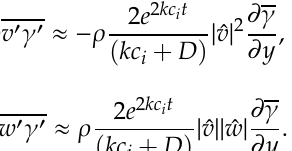
Figure 6. Phase angles for the meridional wind ( ξ v ; black), vertical wind ( ξ w , blue) and dust mixing ratio ( ξ γ ; red) at ( a ) 18 ◦ N and ( b ) 22 ◦ N.